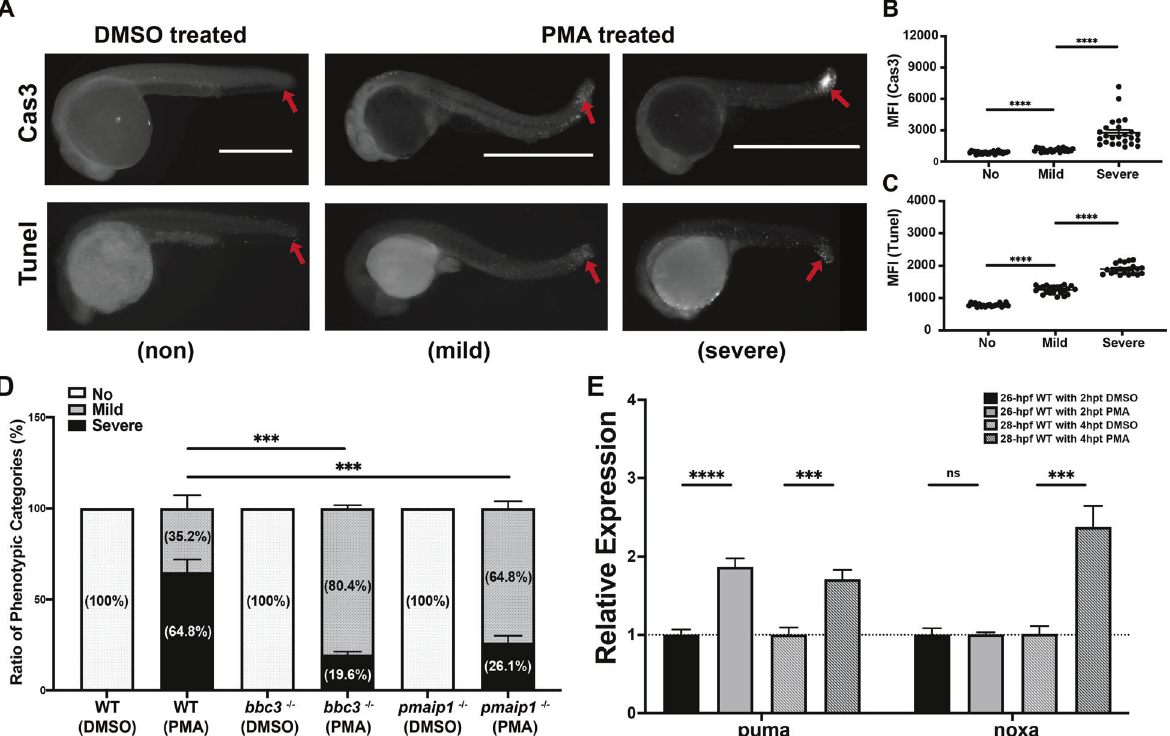
Fig. 7 puma and noxa are required for PMA-induced apoptosis. A Anti-active Caspase-3 (The upper panel) and TUNEL (The Lower Panel) staining on 28 hpf (4 h post treatment) wild-type zebra fi sh embryos with DMSO or DMSO plus 3.3 μ M PMA. Representative fi gures showing phenotypic categories of the apoptotic degree. Arrows points out apoptotic area in tail region in WTembryos with DMSO alone or with DMSO plus 3.3 μ M PMA for 4 h. Scale bar, 1000 μ M. B Quanti fi cation of fl uorescence intensity of tail region of DMSO-treated and PMA-treated embryos in mild and severe categories with anti-active Caspase-3. Each dot represents MFI of the tail region of individual embryos from three independent experiments. Bars represent mean ± SEM. **** p < 0.0001. C Quanti fi cation of the fl uorescence intensity of tail region of DMSO- treated and PMA-treated embryos in mild and severe categories for TUNEL staining. Each dot represents mean fl uorescence intensity (MFI) of the tail region of individual embryos from two independent experiments. Bars represent mean ± SEM. **** p < 0.0001. D Loss of both puma and noxa partially rescued PMA-induced apoptosis at 24 hpf. Percentage of phenotypic categories in wild type, bbc3 − / − and pmaip1 − / − zebra fi sh embryos. n = 4 (wild type and bbc3 − / − ) and n = 7 (pmaip1 − / − ) from pooled embryos per sample. The total number of